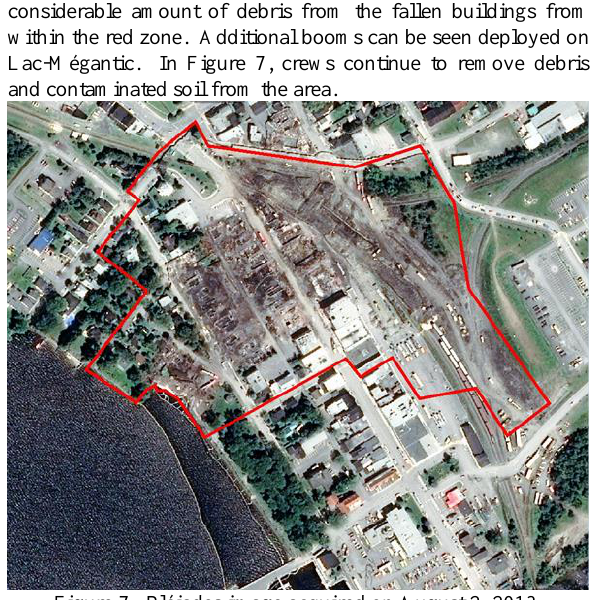
Figure 7. Pléiades image acquired on August 2, 2013.